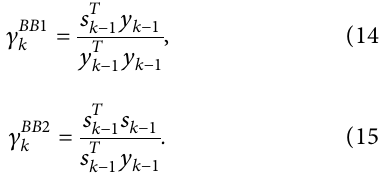
Algorithm 1 and the gain parameter ℷ k : � 1 + α k − α 2 the form of